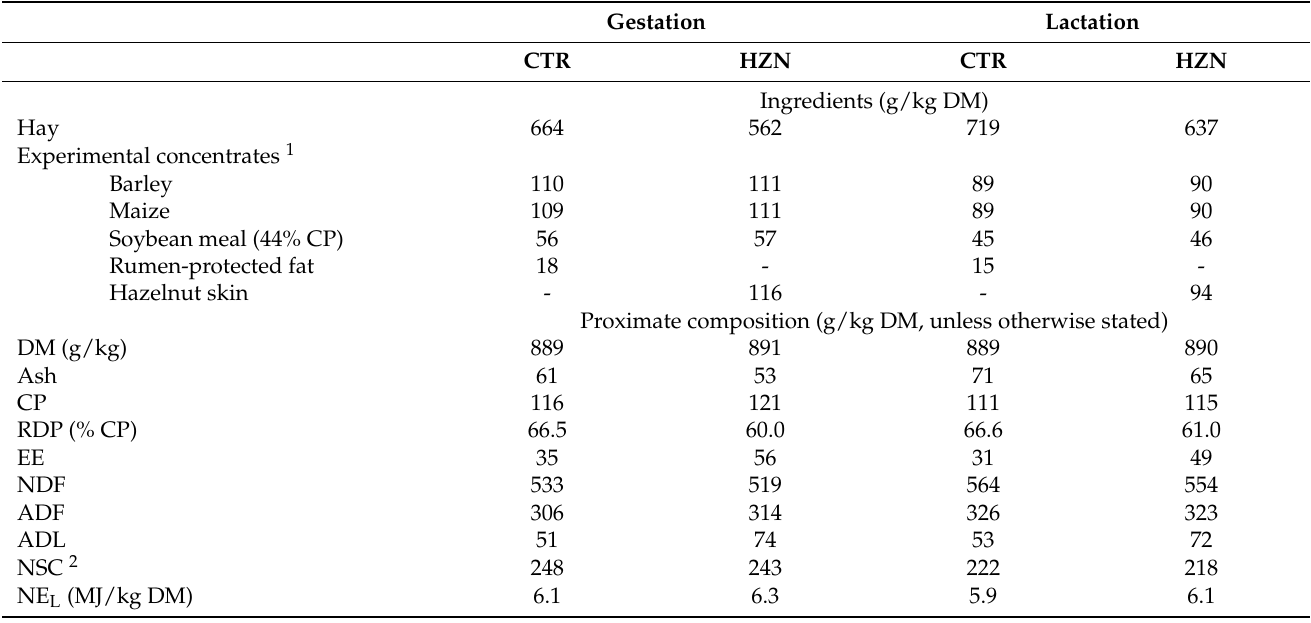
Table 1. Ingredients and proximate composition of the experimental diets for gestation and lactation